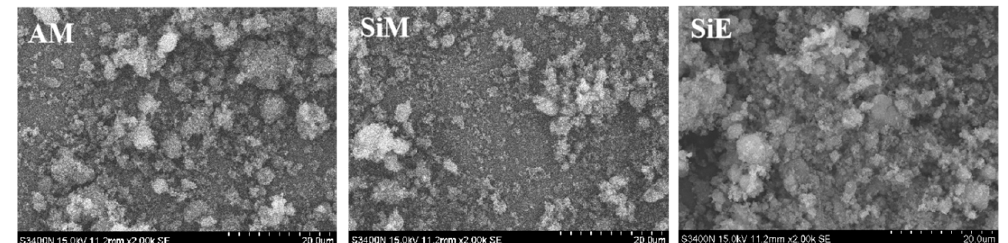
Figure 6. SEM images of AM, SiM, and SiE.